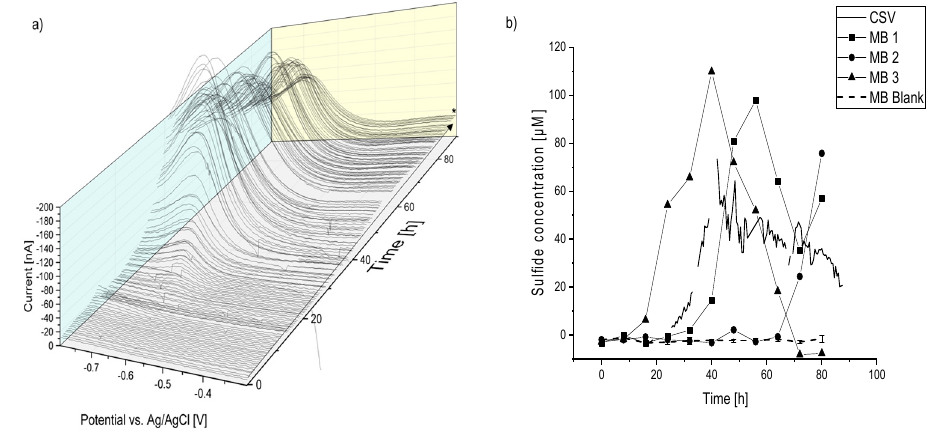
Figure 3. ( a ) Voltammograms of cathodic stripping during GAME calibration and ( b ) respective sulfide calibration curve in type 1 artificial wastewater (AWW 1) at room temperature.